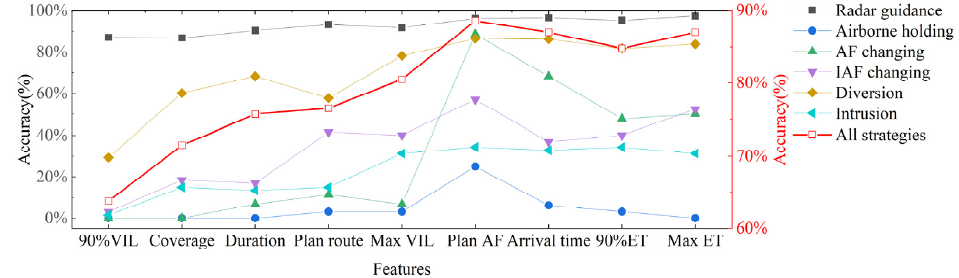
Figure 16. Prediction accuracy change caused by feature selection (ZHHH).